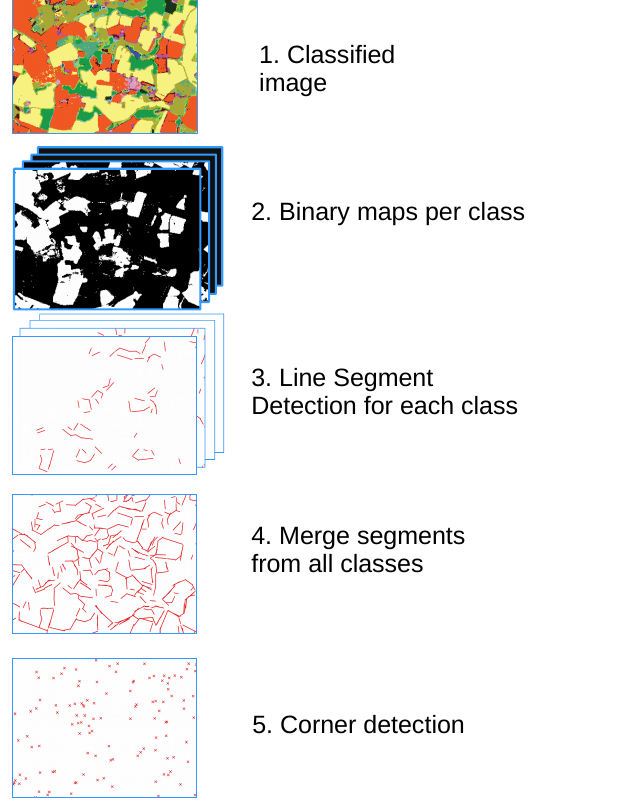
Figure 2. Corner extraction process. First, the image is split into binary maps for each class. Then, the Line Segment Detector is applied on each binary map. In order to extract corners from various classes, the segments are all merged together before the corner detection